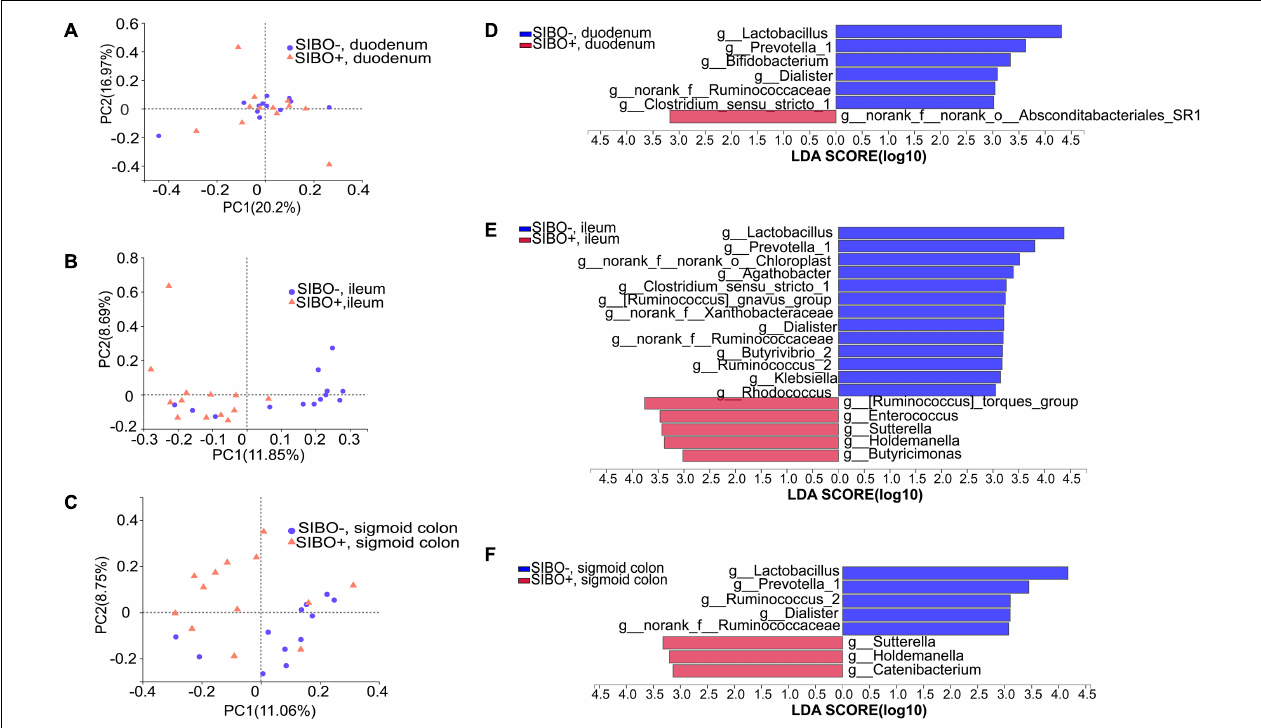
FIGURE 5 | Distinct bacterial composition in the mucosal samples of the SIBO + and SIBO − groups. (A–C) PCoA analysis. The bacterial community compositions were clustered significantly separately between the SIBO + and SIBO − groups in the duodenal mucosa based on abund_jaccard distance (ANOSIM R = 0.102, P = 0.039), in the ileac mucosa based on binary_jaccard (ANOSIM R = 0.216, P = 0.002), and in the mucosa of sigmoid colon based on binary_jaccard (ANOSIM R = 0.155, P = 0.007). (D–F) Linear discriminant analysis (LDA) identified distinct bacterial genera that were enriched in the SIBO + and SIBO − groups. Genera with LDA score > 3 were considered significant. The abundances of 7, 18, and 8 genera differed significantly in the mucosal samples of duodenum, ileum, and sigmoid colon between the SIBO + and SIBO −